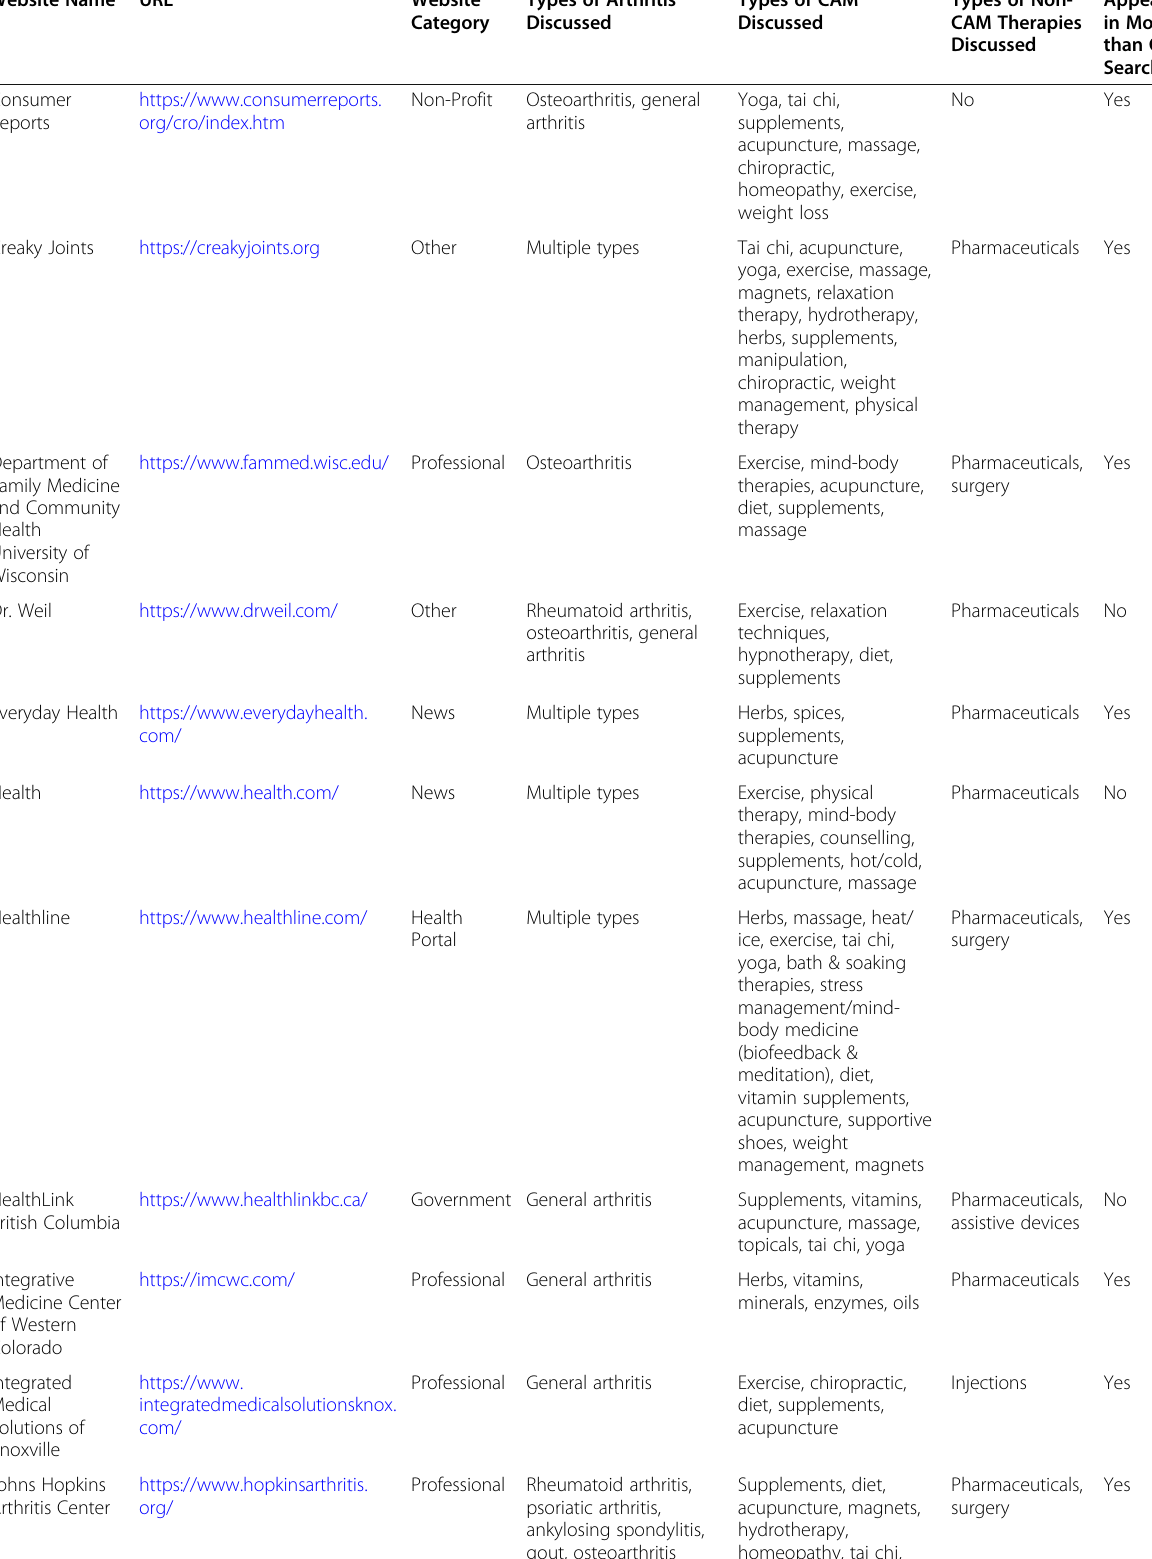
Table 1 General Characteristics of Eligible Websites